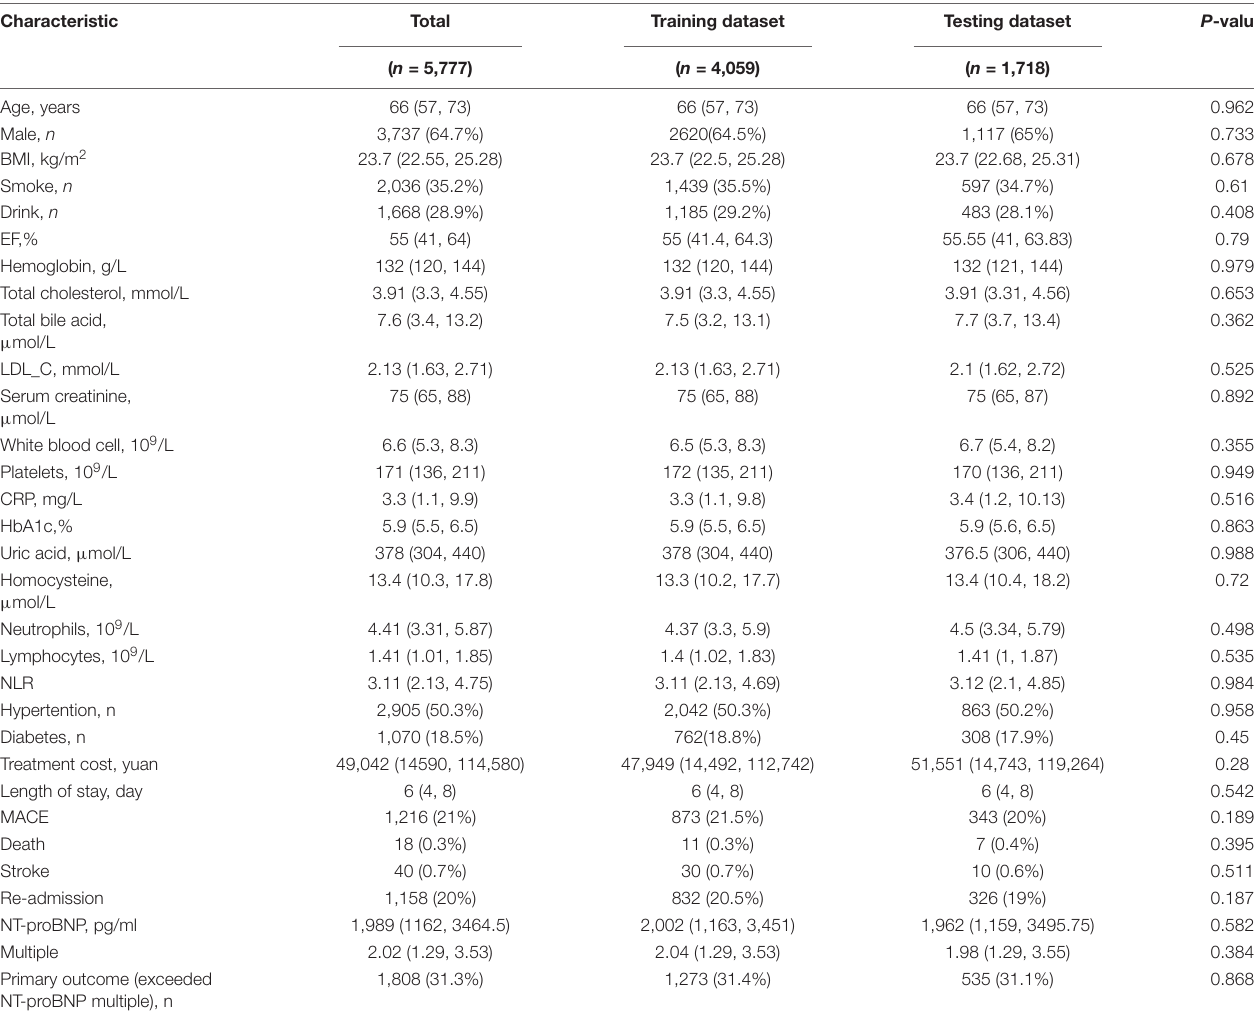
TABLE 1 | Summary of study variables grouped by training and testing datasets.